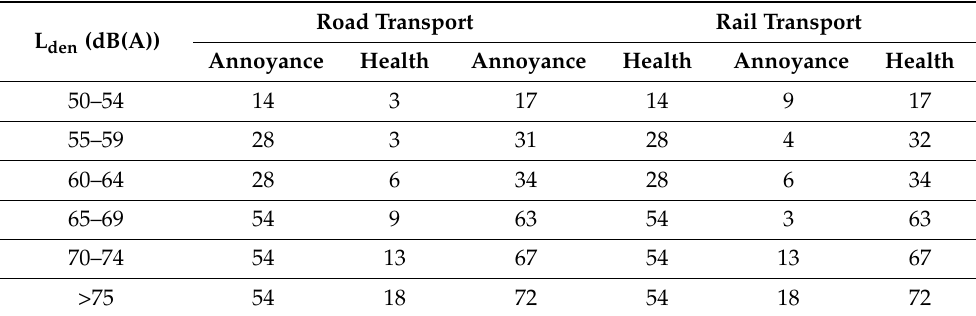
Table 4. Environmental price of road and rail traffic noise combined to determine port noise values for EU28 (2016 EUR/dB/person/year)